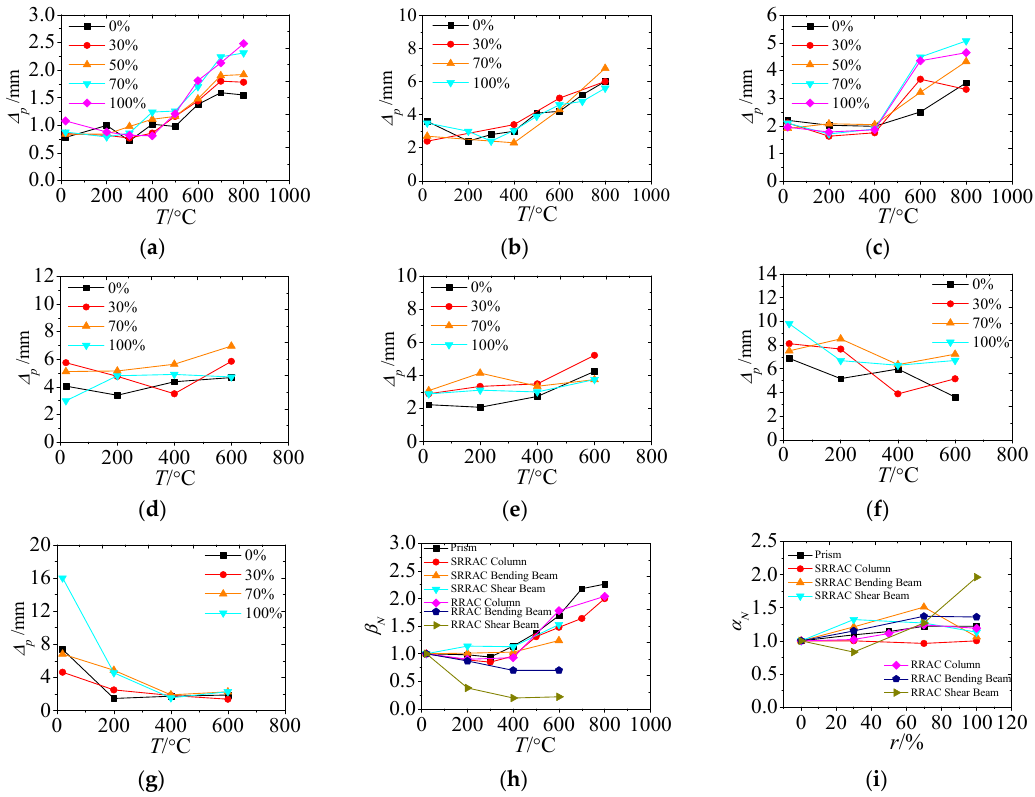
Figure 14. Influence of variation parameters on bearing peak deformation. ( a ) Prism; ( b ) SRRAC column; ( c ) RRAC column; ( d ) SRRAC bending beam; ( e ) SRRAC shear beam; ( f ) RRAC bending beam; ( g ) RRAC shear beam; ( h ) Temperature; ( i ) Replacement percentage.